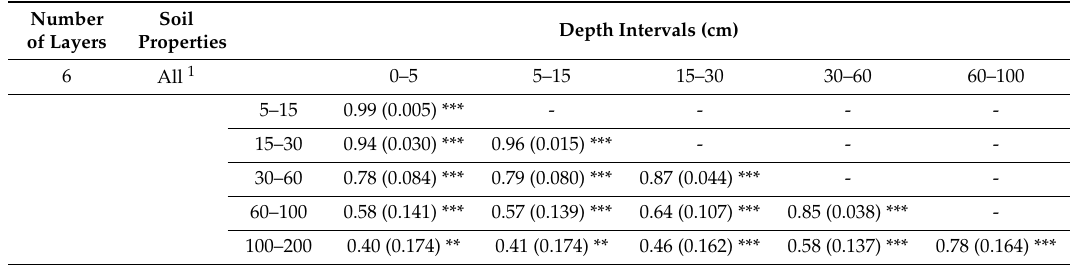
Table 5. Correlations of combined soil properties and available water capacity (AWC) across depths.